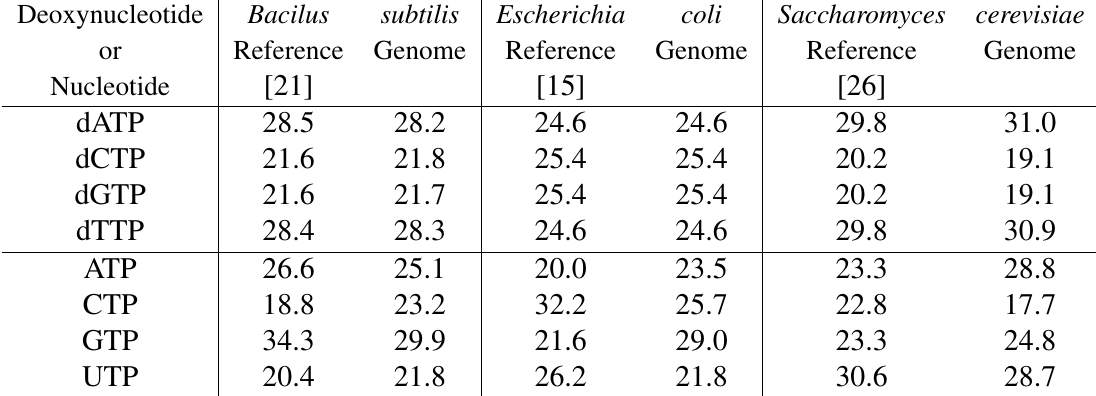
Table 2: Biomass composition in nucleotides and deoxynucleotides estimated from genome infor- mation and obtained from reference. Nucleotide and deoxynucleotide compositions are presented in molar